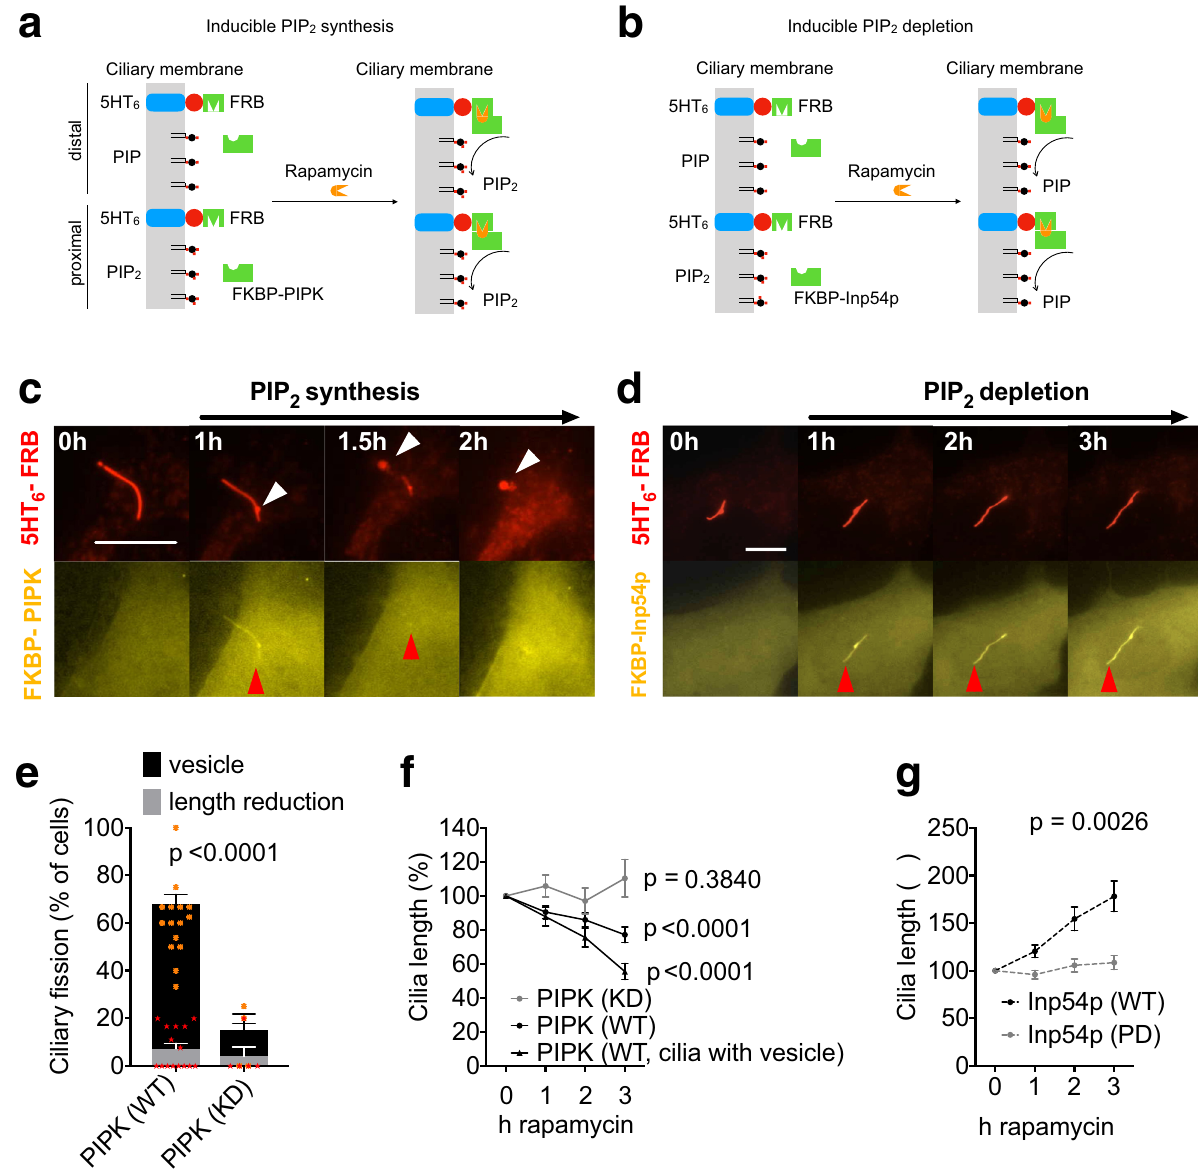
Fig. 1 PIP 2 regulates ciliary length. a , b Schematic representation of inducible PIP 2 synthesis ( a ) and PIP 2 depletion ( b ). The density of PIP 2 is normal in the proximal ciliary membrane but much reduced toward the distal ciliary membrane. Rapamycin-induced dimerization of FRB and FKBP leads to recruitment of the PIP 2 synthesising enzyme PIPK ( a ) or the PIP 2 depleting enzyme Inp54p ( b ) to the cilium. c , e , f PIP 2 increase is suf fi cient for ciliary fi ssion. c Time- lapse images of NIH3T3 cells expressing the ciliary marker 5HT 6 -mCherry-FRB and the CID tool YFP-FKBP-PIPK (WT) acquired at the indicated time points after addition rapamycin (100 nM fi nal). In all fi gures, white arrowheads mark ciliary swellings and secreted vesicles. Red arrowheads mark recruitment of PIPK. Scale bar 10 µ m. e Quanti fi cation of ciliary fi ssion events, de fi ned as either appearance of a vesicle at the ciliary tip (black bars) or reduction in ciliary length by at least 20% (grey bars) in cells treated as in ( c ) from n = 4 – 15 independent experiments. Two-way ANOVA showed signi fi cant effects of the two factors (PIPK WT vs. DN, and vesicle appearance vs. length reduction) and signi fi cant interaction between the two factors. Asterisks represent data of individual experiments, in orange for vesicle appearance and in red for length reduction. f Time course of cilium length as reported by mCherry-tagged 5HT 6 normalised to the length at t = 0. PIPK (WT): n = 96 cilia from 15 experiments as in ( c ). PIPK (KD): n = 18 cilia from 4 independent experiments as in ( c ) but with kinase dead (KD) PIPK instead of WT PIPK. PIPK (WT, cilia with vesicle): Ciliary length in the subset of cells with WT PIPK where a vesicle appeared. d , g PIP 2 depletion leads to ciliary elongation. d Time-lapse images of NIH3T3 cells expressing the ciliary marker 5HT 6 -mCherry-FRB and in addition the CID tool YFP-FKBP-Inp54p. Images were acquired at the indicated time points after addition of rapamycin (100 nM fi nal). Red arrowheads mark recruitment of YFP-FKBP-Inp54p. Scale bar 10 µ m. g Time course of cilium length normalised to the length at t = 0 h in n = 58 cells from 7 independent experiments as in ( d ) and n = 21 cells from 3 independent experiments with phosphatase dead (PD) Inp54p instead of WT Inp54p, two-way